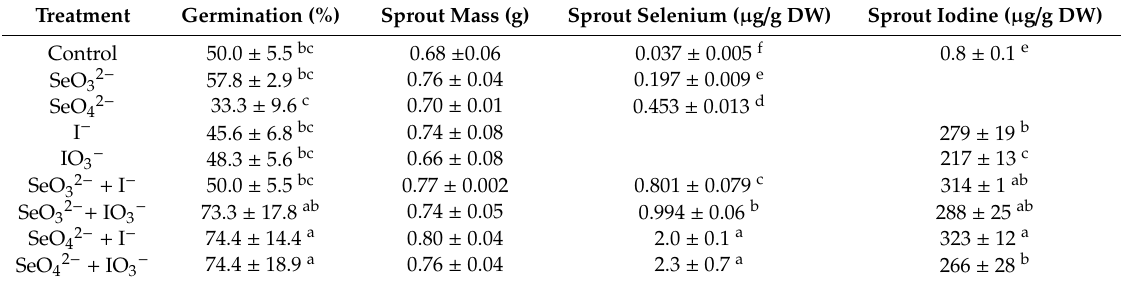
Table 1. E ff ects of the various seed-soaking treatments on the characteristics of the pumpkin sprouts and their Se and I levels. Treatments were based on Se at 10 mg / L and I at 1000 mg / L.